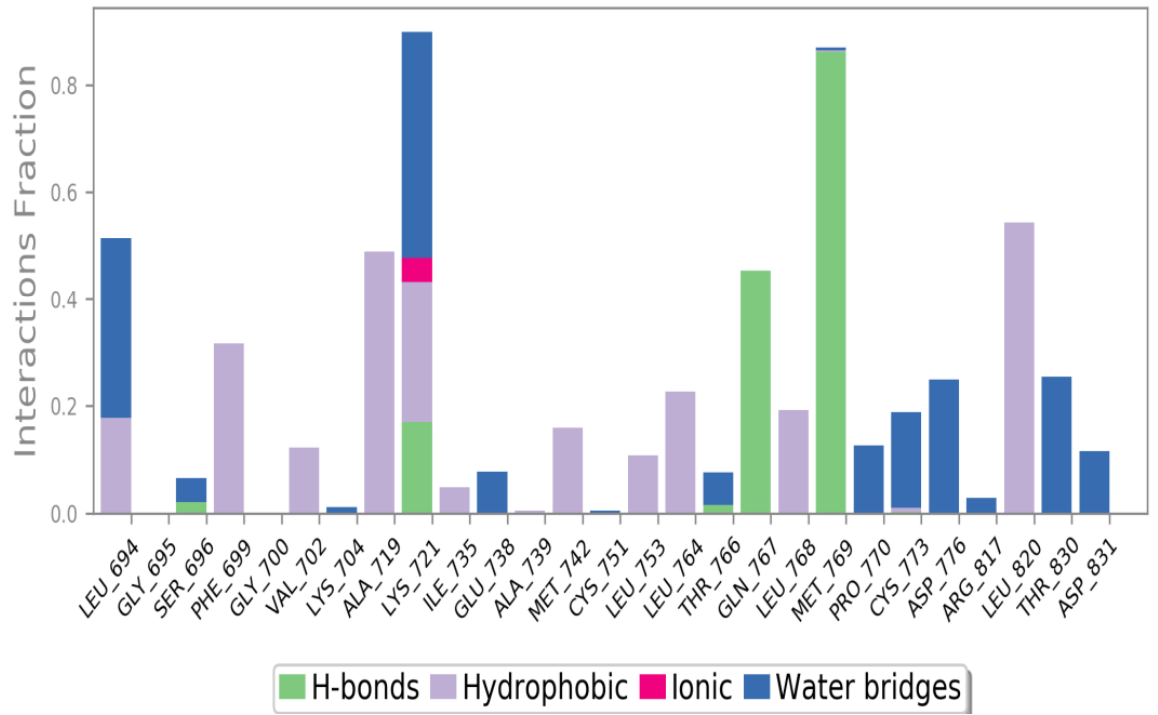
Figure 6. The histogram of 6j -1M17 contact throughout the trajectory.